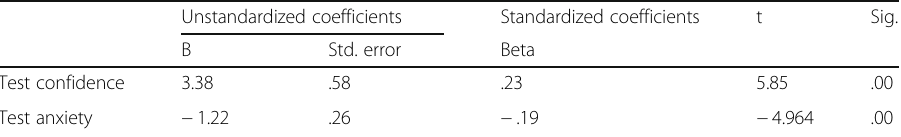
Table 6 Predicting CET-4 performance